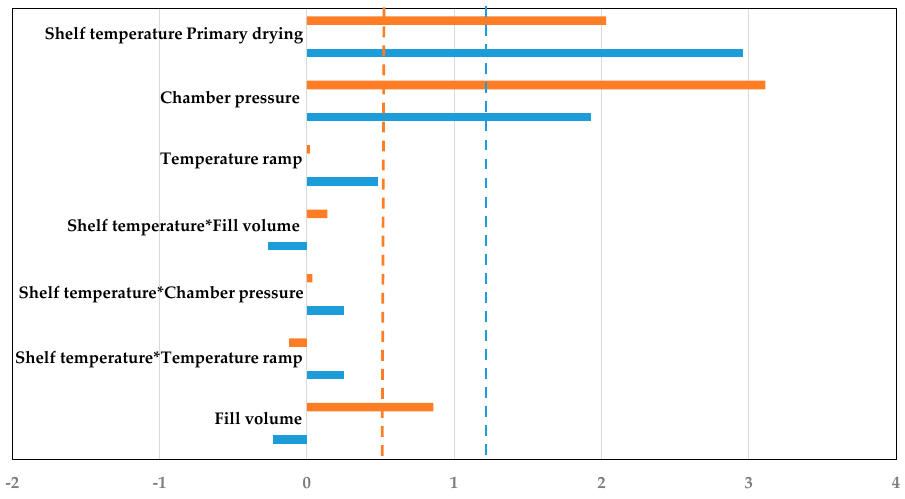
Figure 16. Pareto diagram of standardized effects for primary drying product temperature (blue: Experiment; orange: Simulation, dashed line: significance threshold).